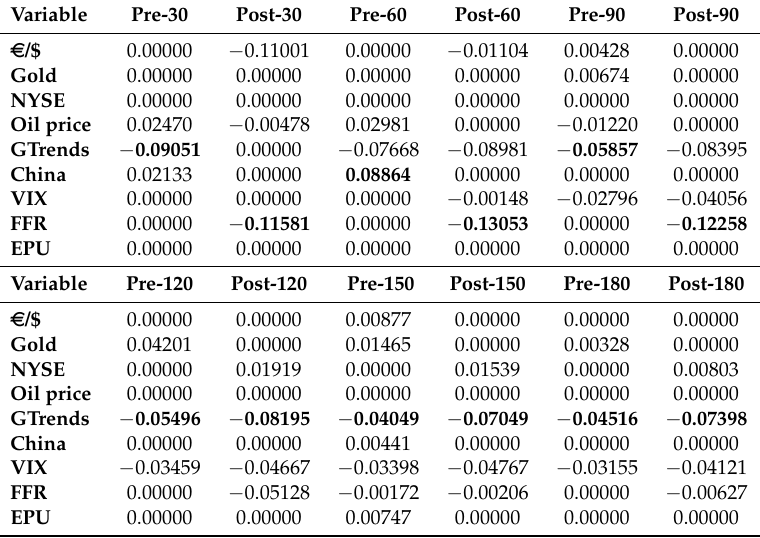
Table A4. PC-LASSO coefficients for